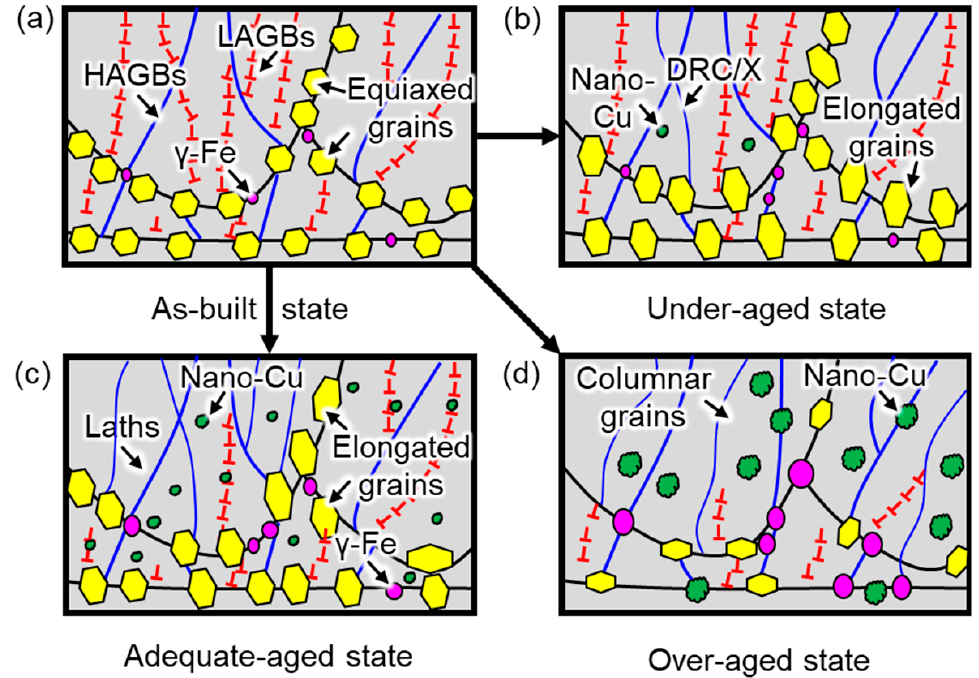
Figure 7. Typical microstructural evolution of the different aged states: ( a ) as-built; ( b ) under-aged; ( c ) adequate-aged; ( d ) over-aged.